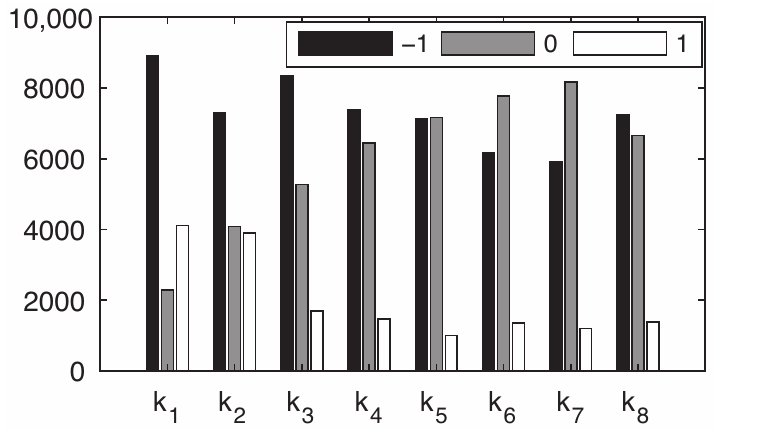
Figure 4. Histogram of k i values.